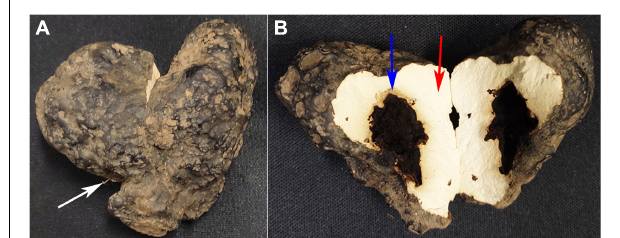
FIGURE 1 | Different partspc collected from Polyporus umbellatus sclerotia. (A) Represents the whole P. umbellatus sclerotium with A. mellea rhizomorph (white arrow) invading the sclerotium. (B) Is a vertical section of P. umbellatus sclerotium. The position marked with the blue arrow represents the wall of the cavities in sclerotia infected by A. mellea (the QR part). The part marked with the red arrow stands for the uninfected part of P. umbellatus sclerotium without A. mellea (the control